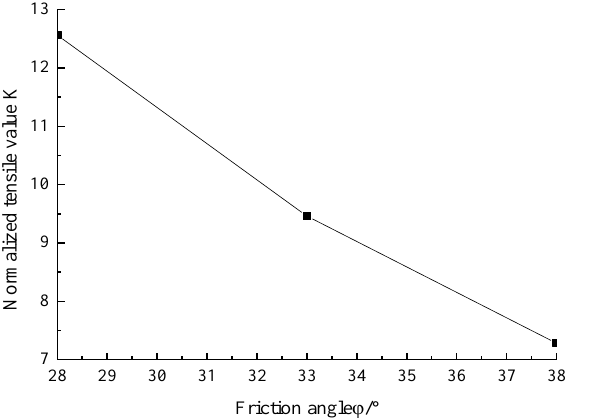
Figure 11. Effect of soil friction angle on normalized tensional force of reinforcement.